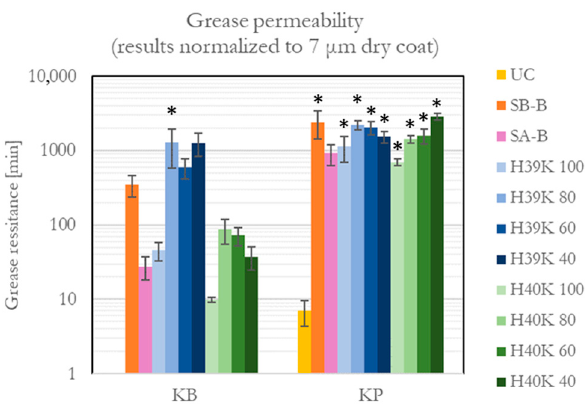
Figure 7. Grease permeability values for the uncoated (UC), commercial (SA-B and SB-B), and experimental dispersion coatings. An asterisk (*) represents the samples that reached the end of the test.